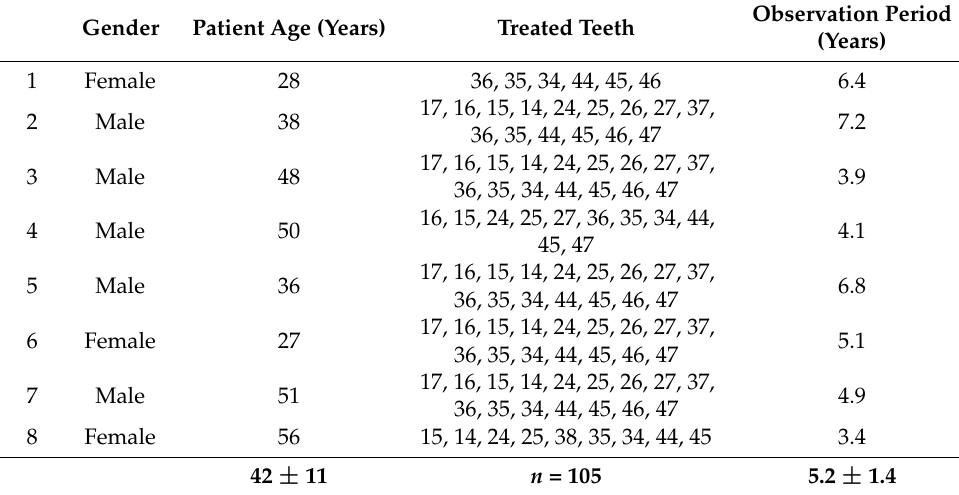
Table 2. Patients and teeth involved (second